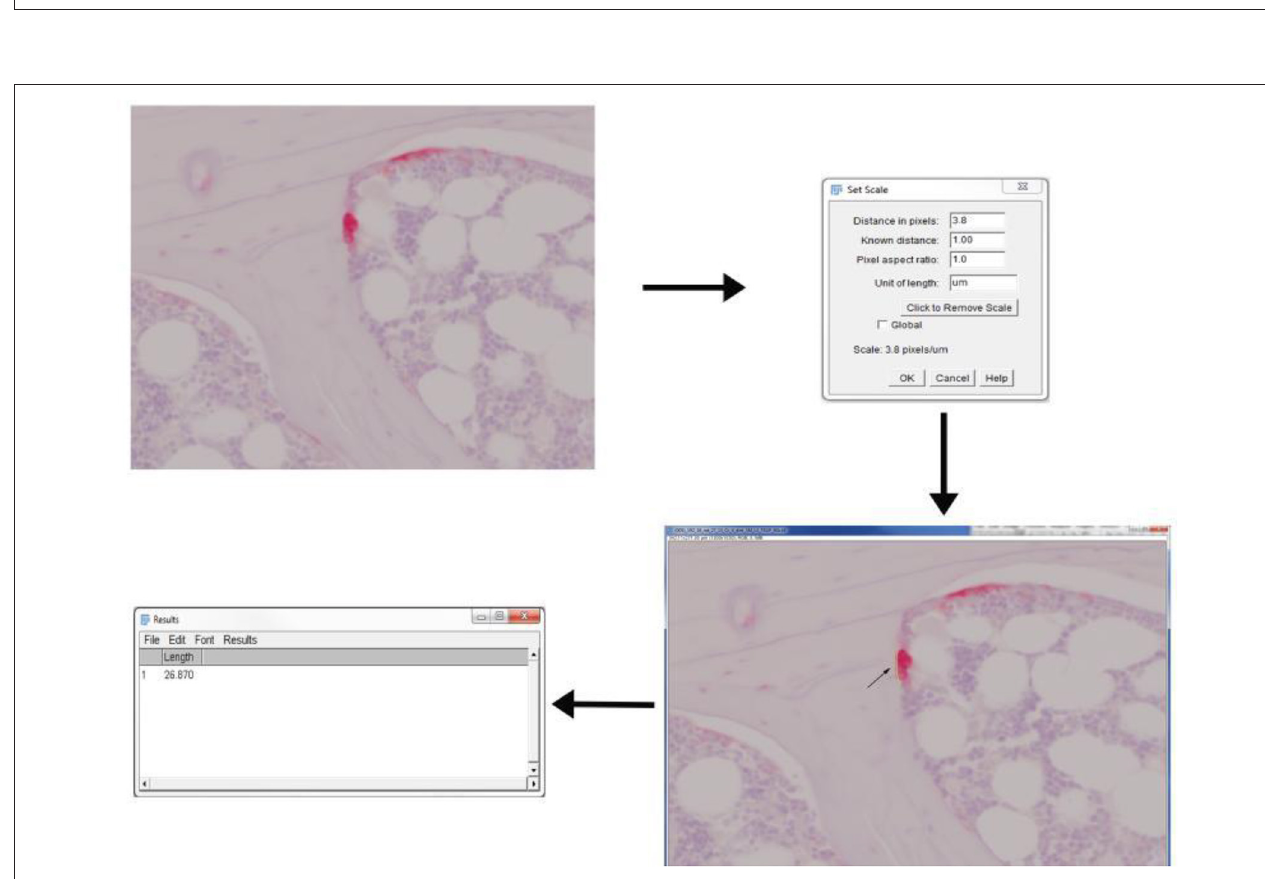
FIGURE 4 | Application of ImageJ toolbox to measure osteoclast activity from TRAP stained sections. Rat vertebral sample was used to perform TRAP enzyme histochemistry. Osteoclasts are identified as multi-nucleated TRAP positive cells near the bone surface. The scale was set up before proceeding with measurements. The length of ruffled borders (arrows) govern the osteoclast activity. The length of ruffled border was measured using free-hand line tool after the scale was set.